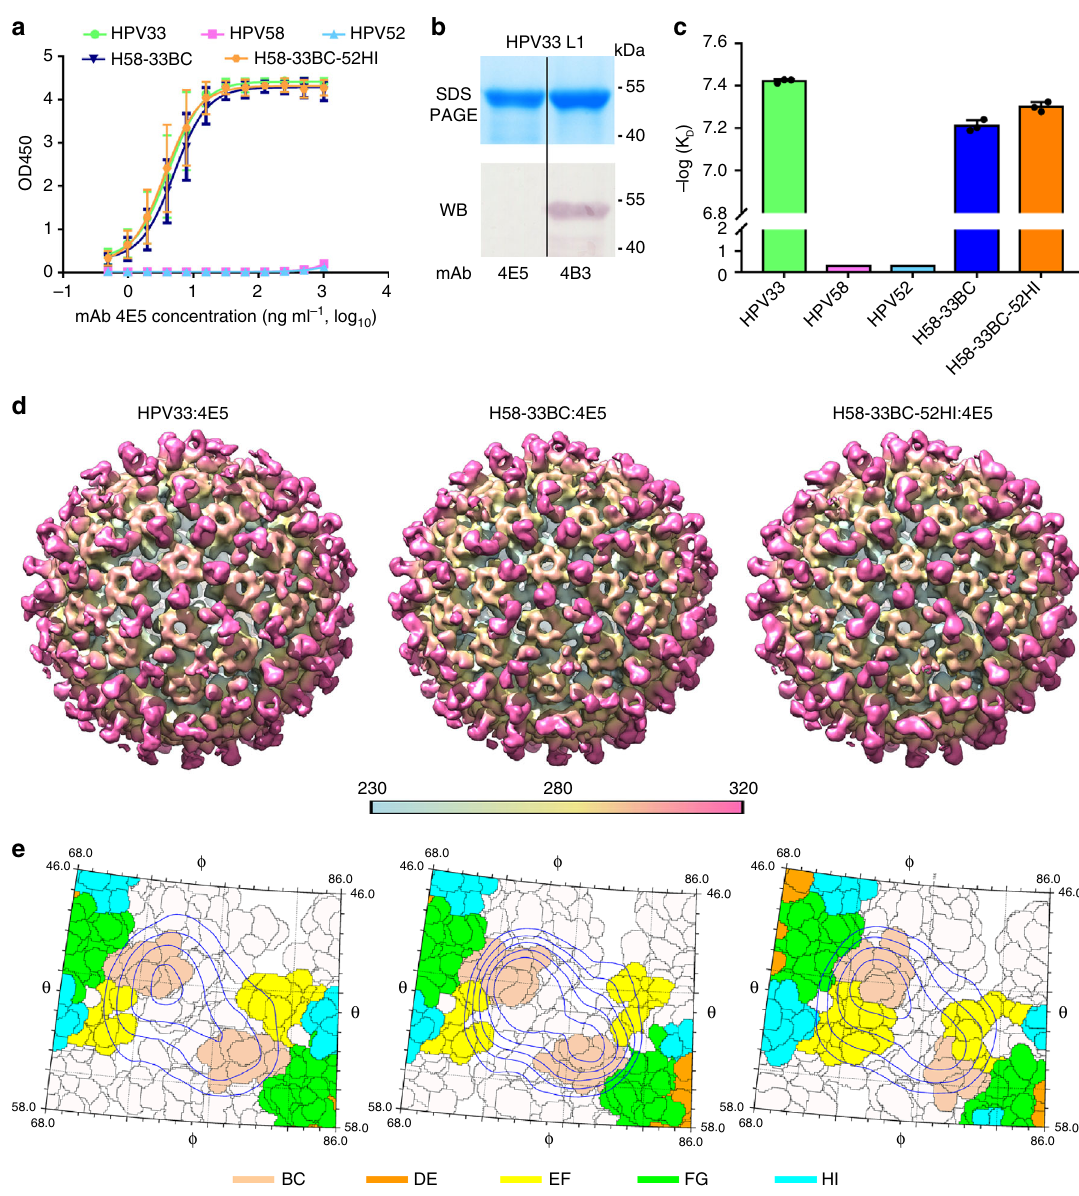
Fig. 8 Structural characterization of the chimeric pentamers and VLPs-Fab immune complexes. a Binding pro fi les of mAb 4E5 to chimeric mutant and WT VLPs of HPV33, HPV52 and HPV58. Data indicates mAb 4E5 can bind to WT VLPs of HPV33 and chimeric VLPs of H58-33BC and H58-33BC-52HI but fails to bind to WT VLPs of HPV52 and HPV58. The error bars are standard deviation of experiments performed in duplicate. b HPV33 L1 protein was subjected to reducing SDS-PAGE and western blot (WB) analysis with mAb 4E5. mAb 4B3, a linear antibody capable of recognizing HPV L1 protein, was employed as a positive control for the WB experiment. c Af fi nity constants of the chimeric mutants (H58-33BC and H58-33BC-52HI) and WT VLPs (HPV33, HPV52 and HPV58) against mAb 4E5 were measured by surface plasma resonance (SPR) in a Biacore 3000. The error bars are standard deviation of experiments performed in triplicate. d CryoEM structures of the VLPs-Fab complexes of HPV33:4E5 (left), H58-33BC:4E5 (middle) and H58- 33BC-52HI:4E5 (right). Density maps are colored by radius from cyan (230 Å), to yellow (280 Å), to pink (320 Å). Icosahedral 2-, 3- and 5-fold axes are indicated by black symbols. For the purpose of comparability, the cryoEM maps at higher resolution were low-pass fi ltered to 12.3 Å. e Close-up view of the roadmaps of HPV33:4E5 (left), HPV58-33BC:4E5 (middle) and HPV58-33BC-52HI (right) surfaces, projected by an area surrounding a 5-fold vertex de fi ned with a polar angle θ range of 46° to 58° and a polar angle ϕ range of 68° – 86°. Color scheme for surface residues are according to surface loops (BC, amber; DE, orange; EF, yellow; FG, green and HI, Cyan). Blue contour lines were drawn according to the projection of the Fab-4E5 entity with a density greater than 1 and within a radial section of the VLP-4E5 complex ranging from 310 Å to 360 Å. The icosahedral symmetry axes are labeled. The roadmaps were generated by the software RIVEM elicit protective immunity against 20 types of HPV through seven hypothetically cover more than 99% of HPV infection that cause chimeric VLPs, along with carcinogenic HPV types from group 4, cervical cancers 45 . Increasing the immunity of conserved neutralizing epitopes and other low-risk types (e.g., HPV6 and HPV11, which are not offers a logical strategy for the design of broadly protective associated with cervical cancer, but are linked with precancerous or immunogens; this would be based on a molecular understanding dysplastic lesions and genital warts) (Fig. 1a). This would